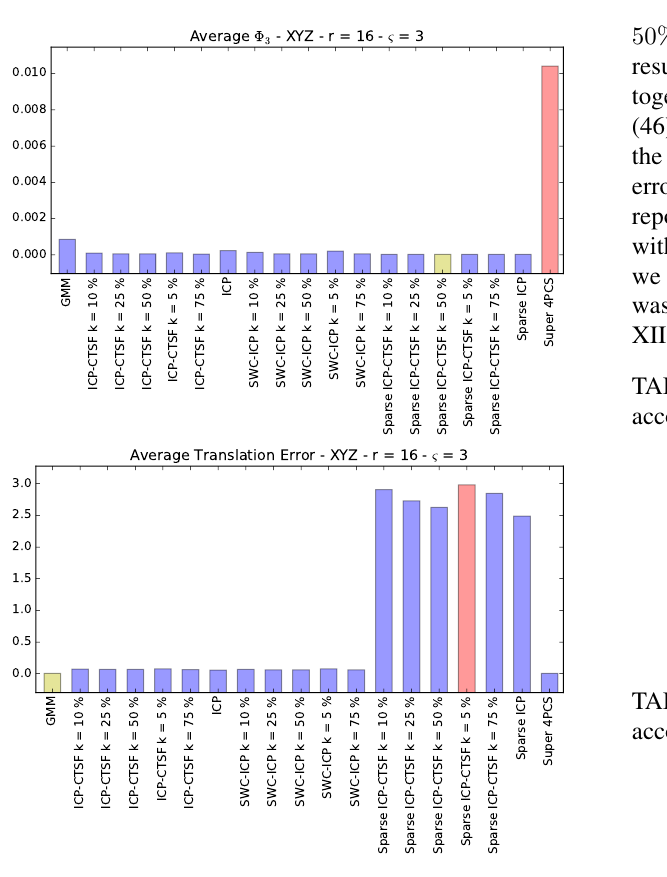
Fig. 23: Results for video ‘freiburg2 xyz’ : (a) Mean rotation error given by expression (47). (b) Translation error computed by expression (48). TABLE XI: Best seven methods for video ‘freiburg2 xyz’ according to the rotation average (equation (47)) with standard deviations given by expressions (49).